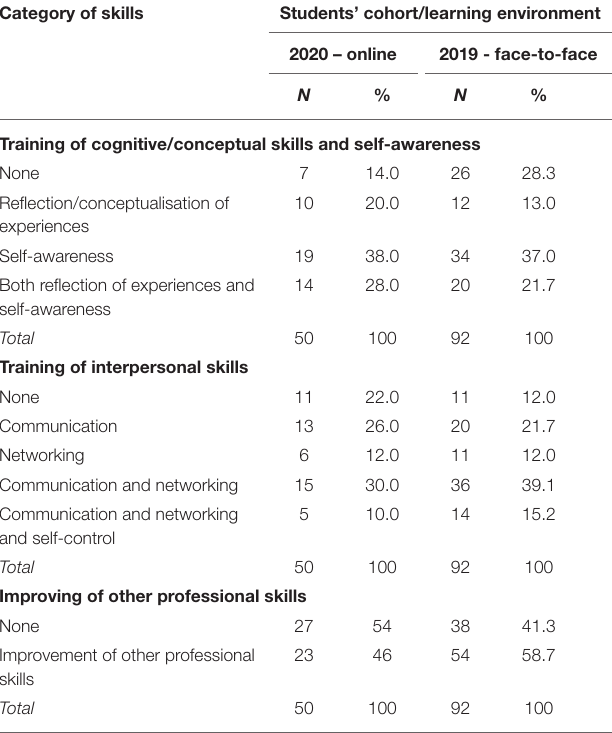
TABLE 1 | Descriptive statistics on the skills students declared they acquired through the participation at the social work methods with groups workshops by cohort/learning environment of students.